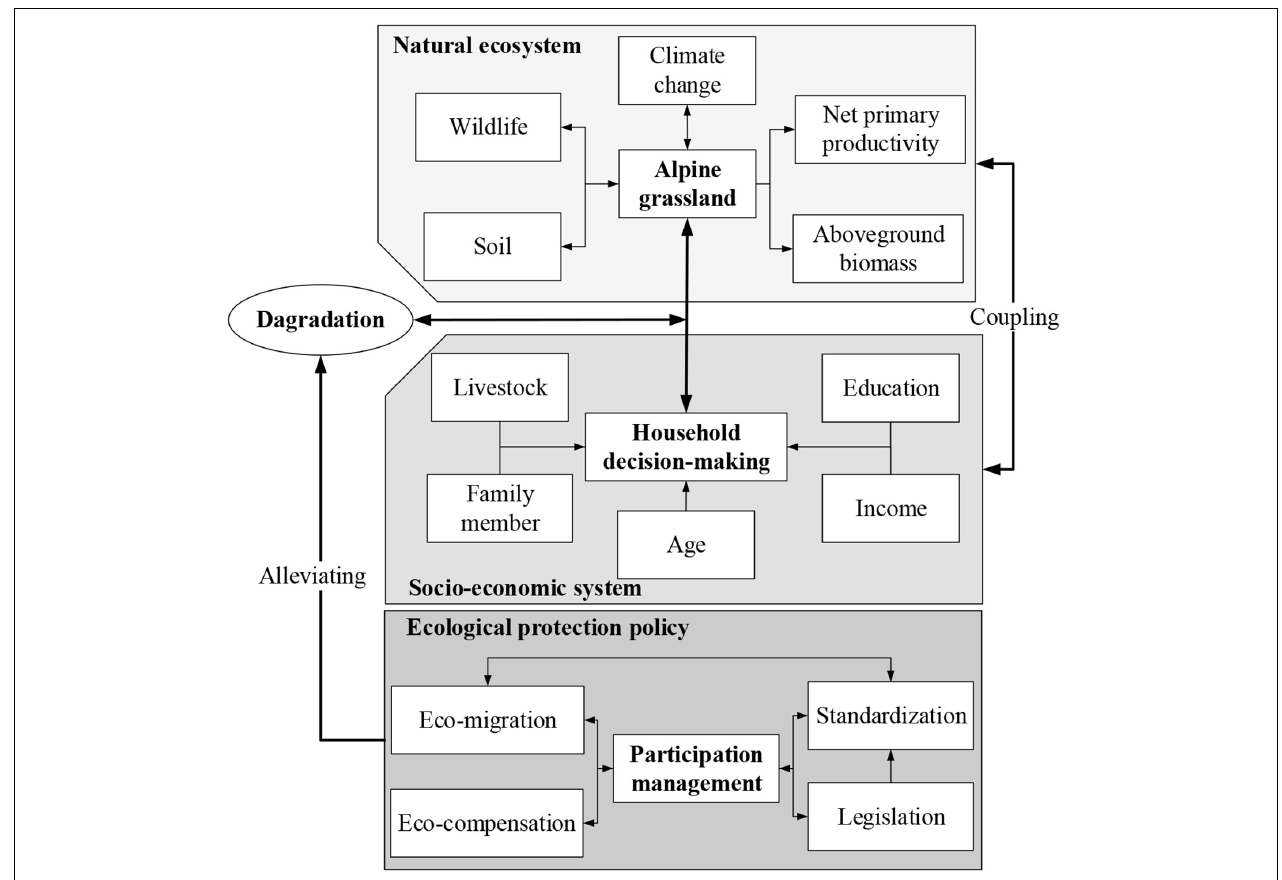
FIGURE 8 | Management framework to alleviate alpine grassland degradation and to enhance the wellbeing of local households based on coupling natural and socioeconomic systems.